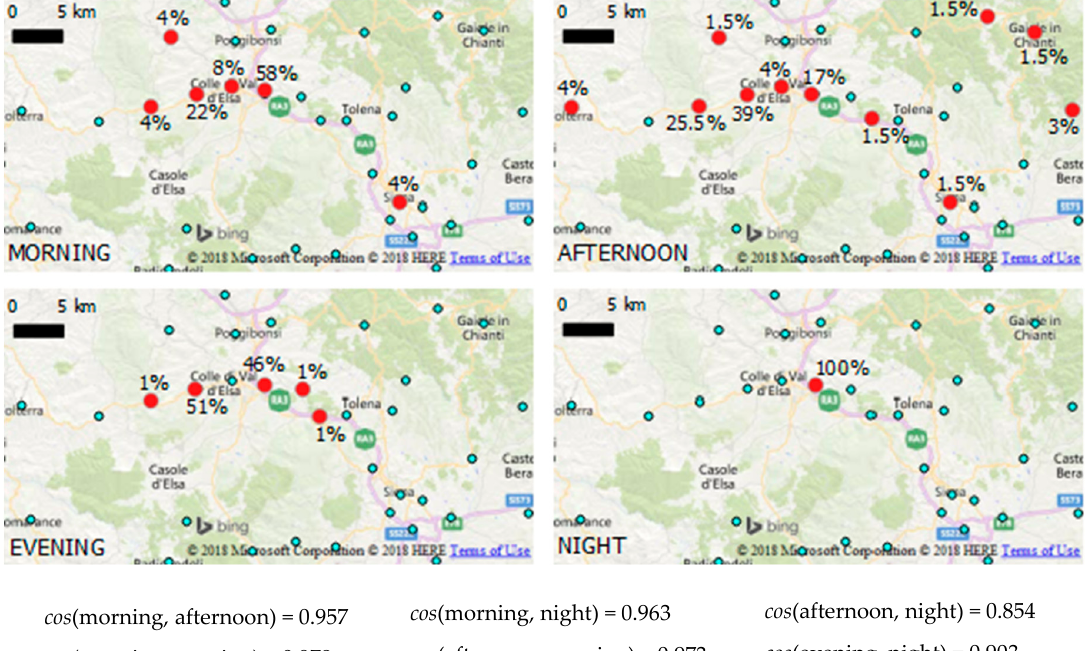
Figure 16. Similarity comparison between motion behaviors of a user (over several days) during different parts of the day: morning (6:00 a.m.–12:00 p.m.), afternoon (12:00 p.m.–6:00 p.m.), evening (6:00 p.m.–12:00 a.m.), and night (12:00 a.m.–6:00 a.m.). For each spot, we reported the percentage of